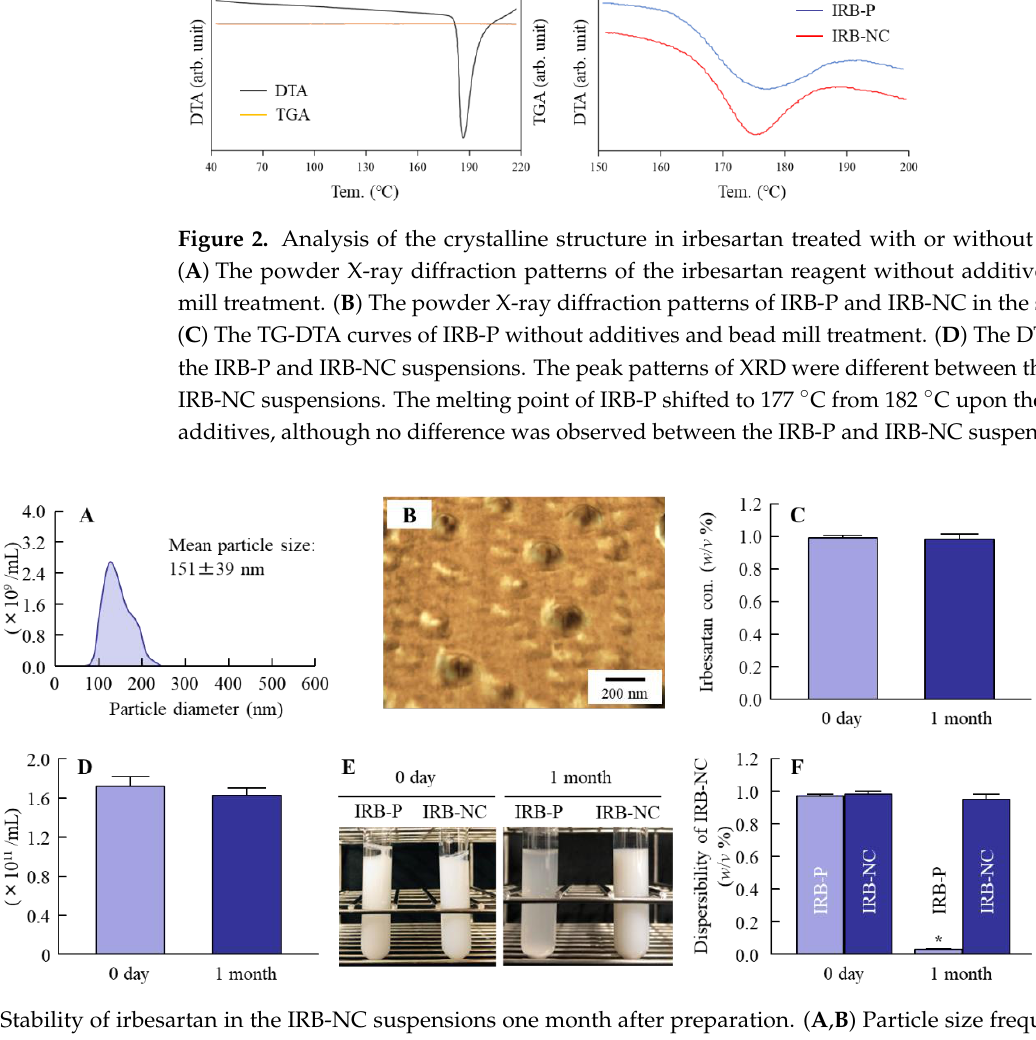
Figure 3. Stability of irbesartan in the IRB-NC suspensions one month after preparation. ( A , B ) Particle size frequencies ( A ) and AFM image ( B ) of irbesartan in the IRB-NC suspensions. ( C , D ) Changes in the concentration ( C ) and particle number ( D ) of irbesartan in the IRB-NC suspensions. ( E , F ) Representative pictures ( E ) and dispersibility ( F ) of the IRB-P and IRB-NC suspensions one month after preparation. n = 6. * p < 0.05 vs. 0 days for each category. The aggregation and degradation of irbesartan in the IRB-NC suspensions were not observed for one month.